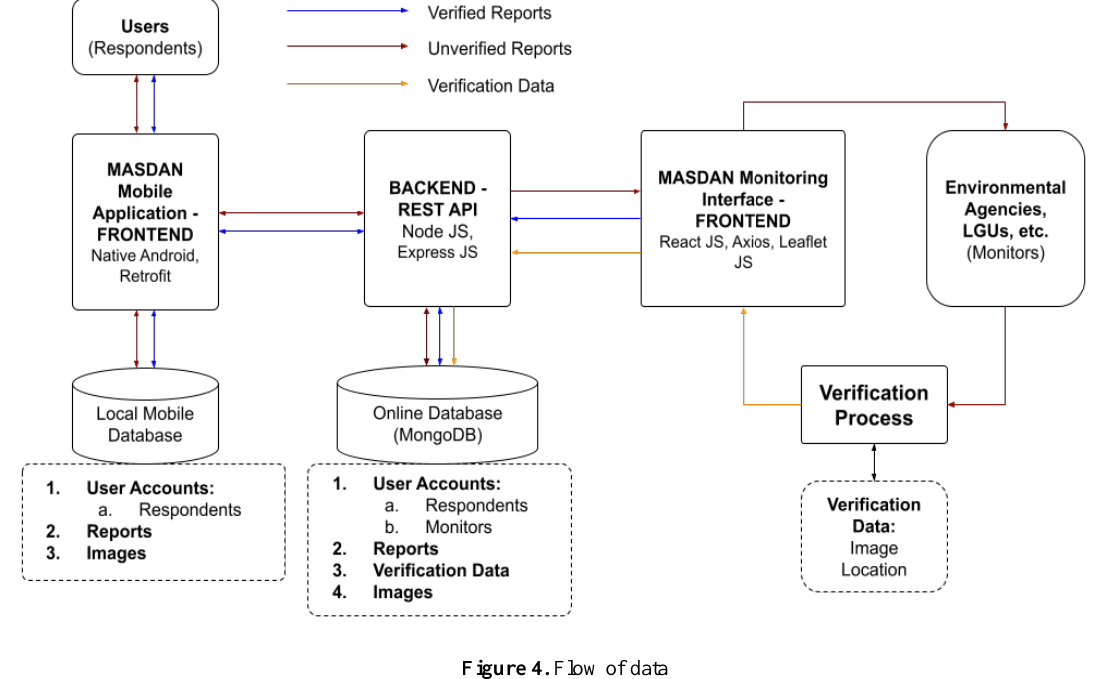
Figure 4. Flow of